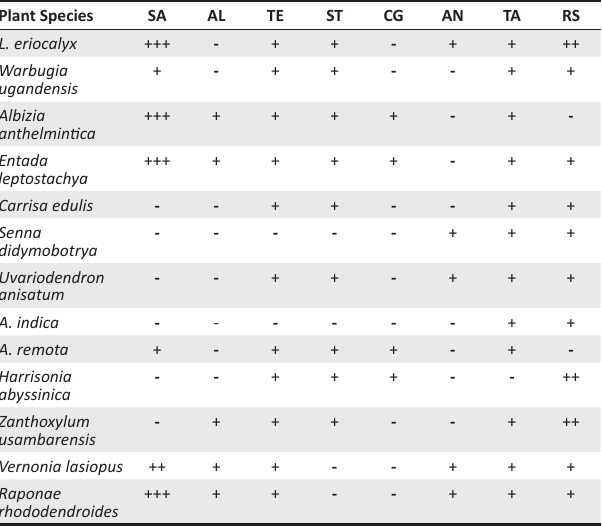
TABLE 2: Phytochemical profiles of the aqueous plant extracts. Plant Species